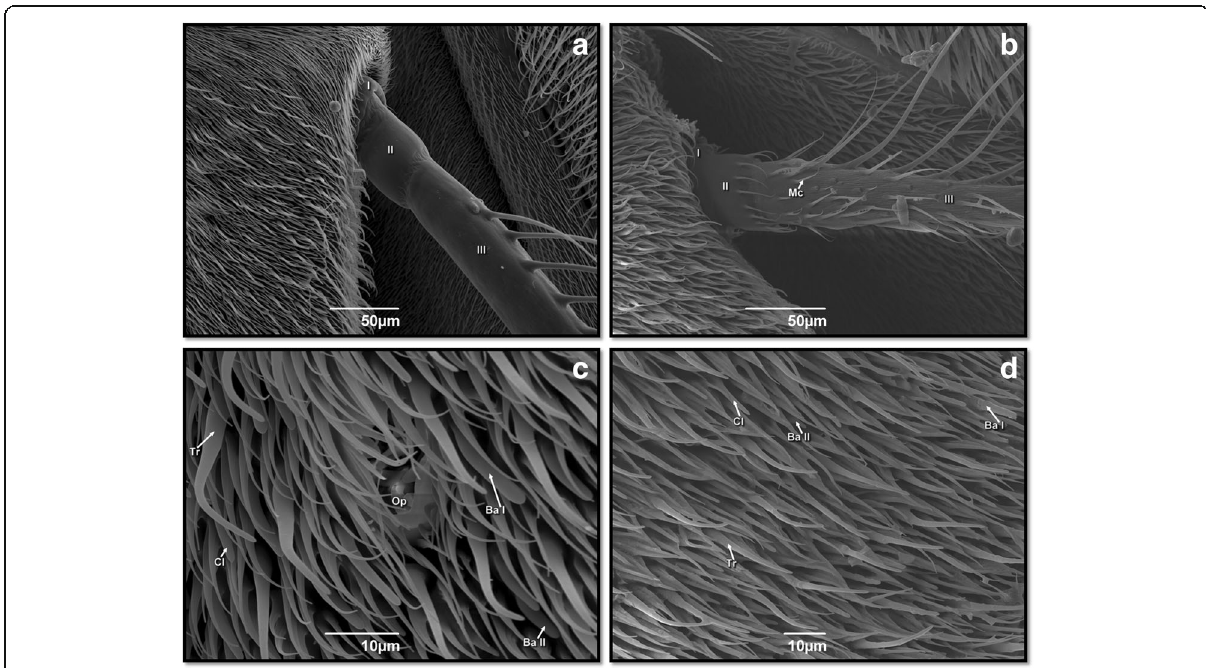
Fig. 7 Scanning electron micrographs showing the cuticular surface of flagellum in both gender of Mesembrinella bicolor : a arista of female divided in three (I-III) segments (× 430), b arista of male divided in three (I-III) segments (× 500), c first flagellomere of female (× 2,300), d first flagellomere of male (× 1,300). Fn = first flagellomere; Mc = microtrichia; Tr = trichoidea; Ba = basiconic; Cl = clavate; Op = Olfactory pits